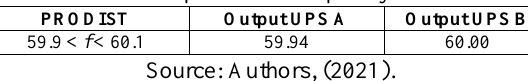
Table 9: Comparison of frequency